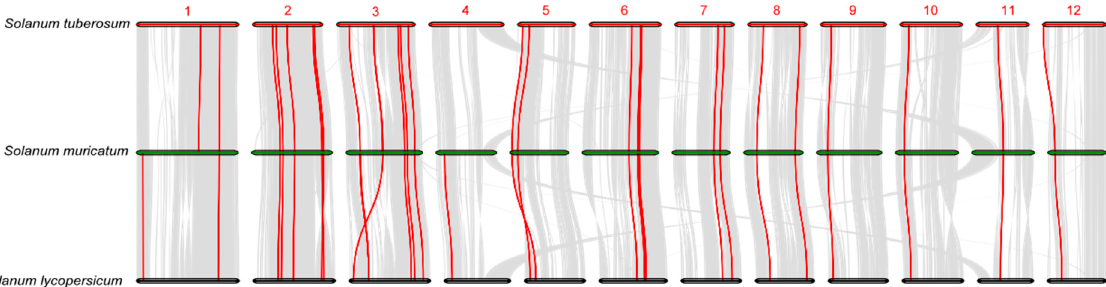
Figure 5. Chromosomal distribution and collinearity analysis of TCP genes in S. lycopersicum , S. tuberosum , and S. muricatum . Note: Gray lines in the background represent the collinear blocks within the genomes of S. muricatum and other Solanum species, while the red lines show the collinear TCP gene pairs.